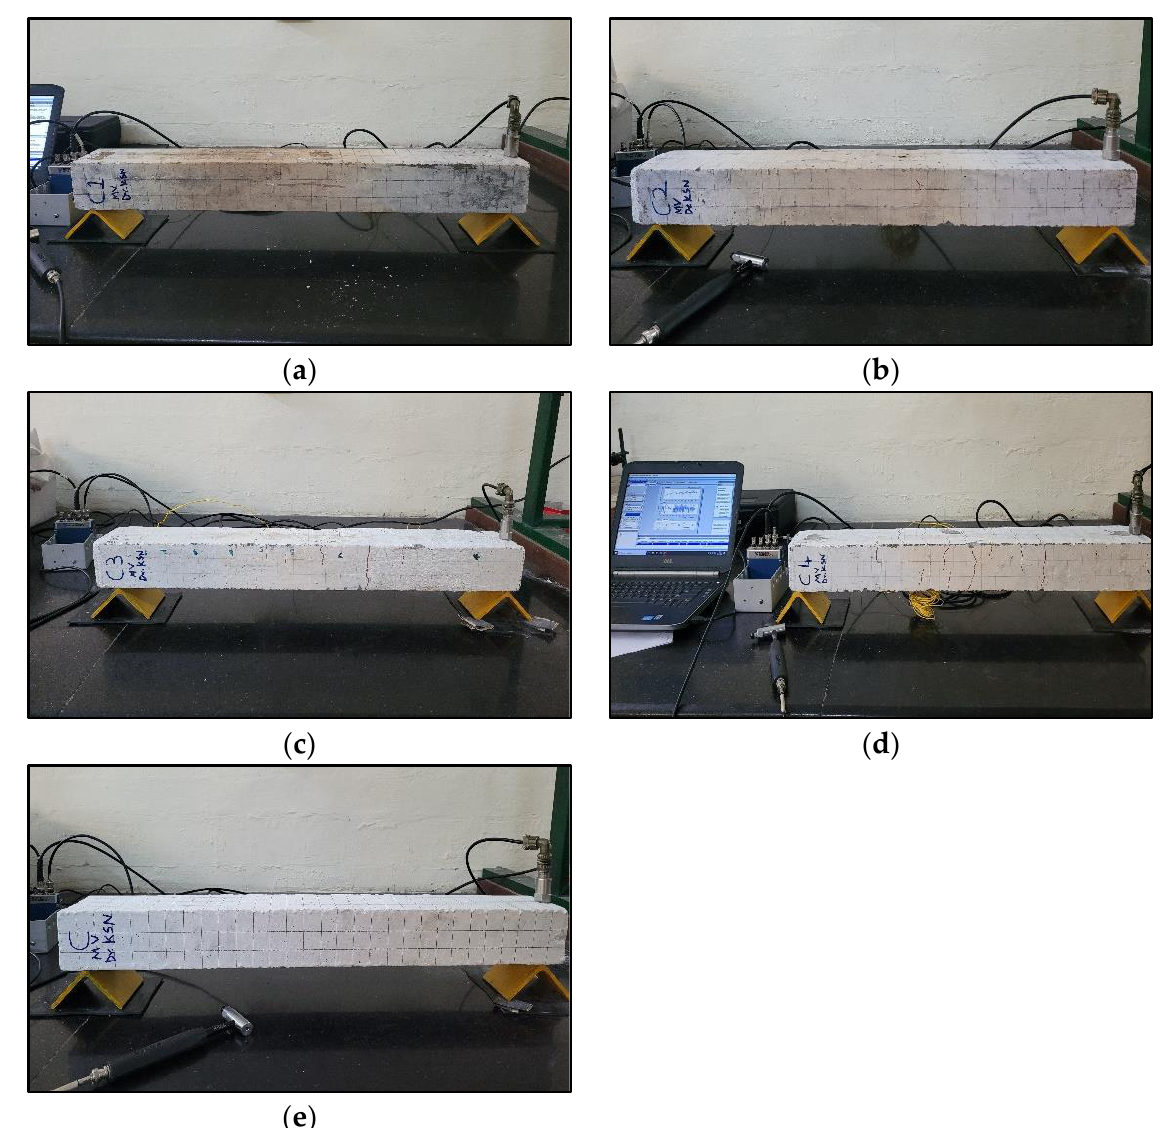
Figure 25. The schematic test arrangement for observing natural frequency.